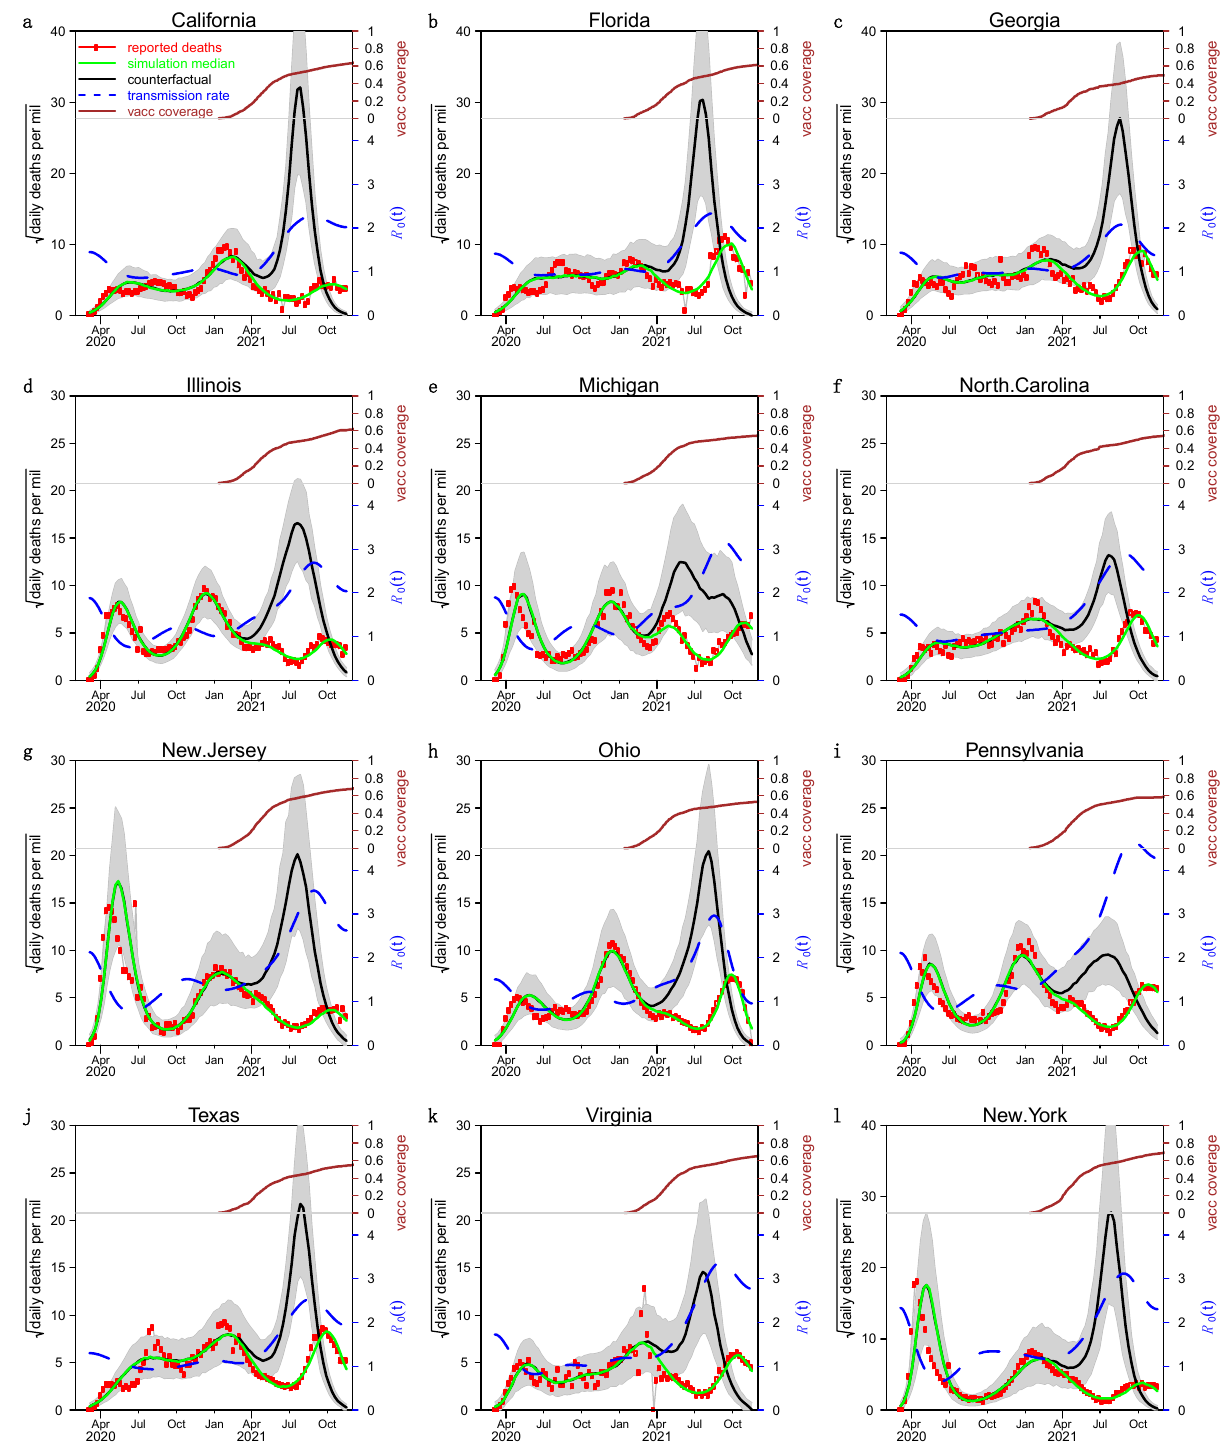
Figure 2. Fitting results under case 1. Panels ( a – l ) The model fit for the 12 most populous states in the US applying the first approach, respectively. Brown curves in the top of the panel show the vaccination (fully vaccinated) in each state. Red circles and green curves are observed and simulated (median, based on 1000 stochastic simulation runs) COVID-19 deaths. The black curve shows the simulated median under the scenario without vaccination. The blue dashed curve indicates the estimated transmission rate.